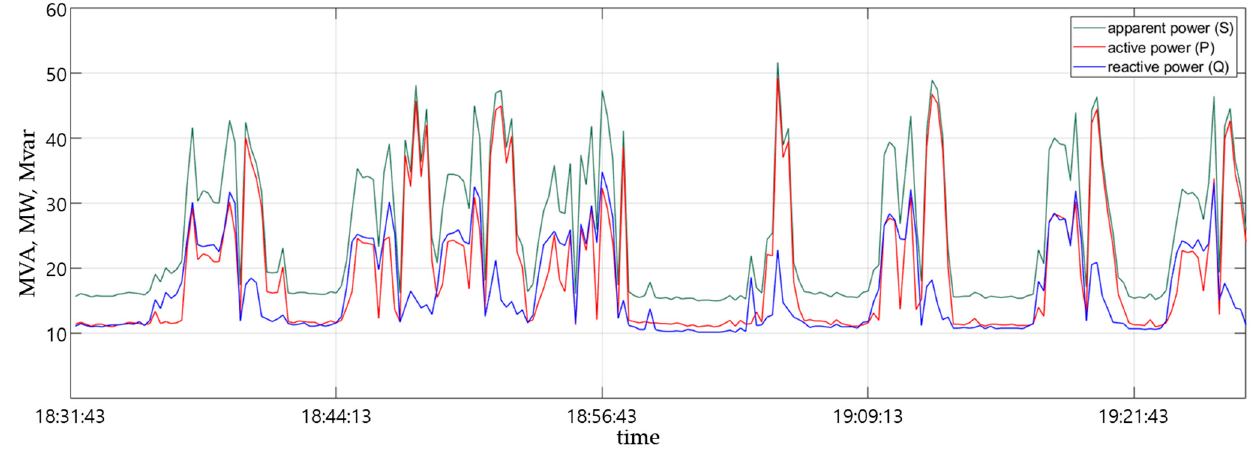
Figure 1. Measured P, S, and Q on plate mill system.